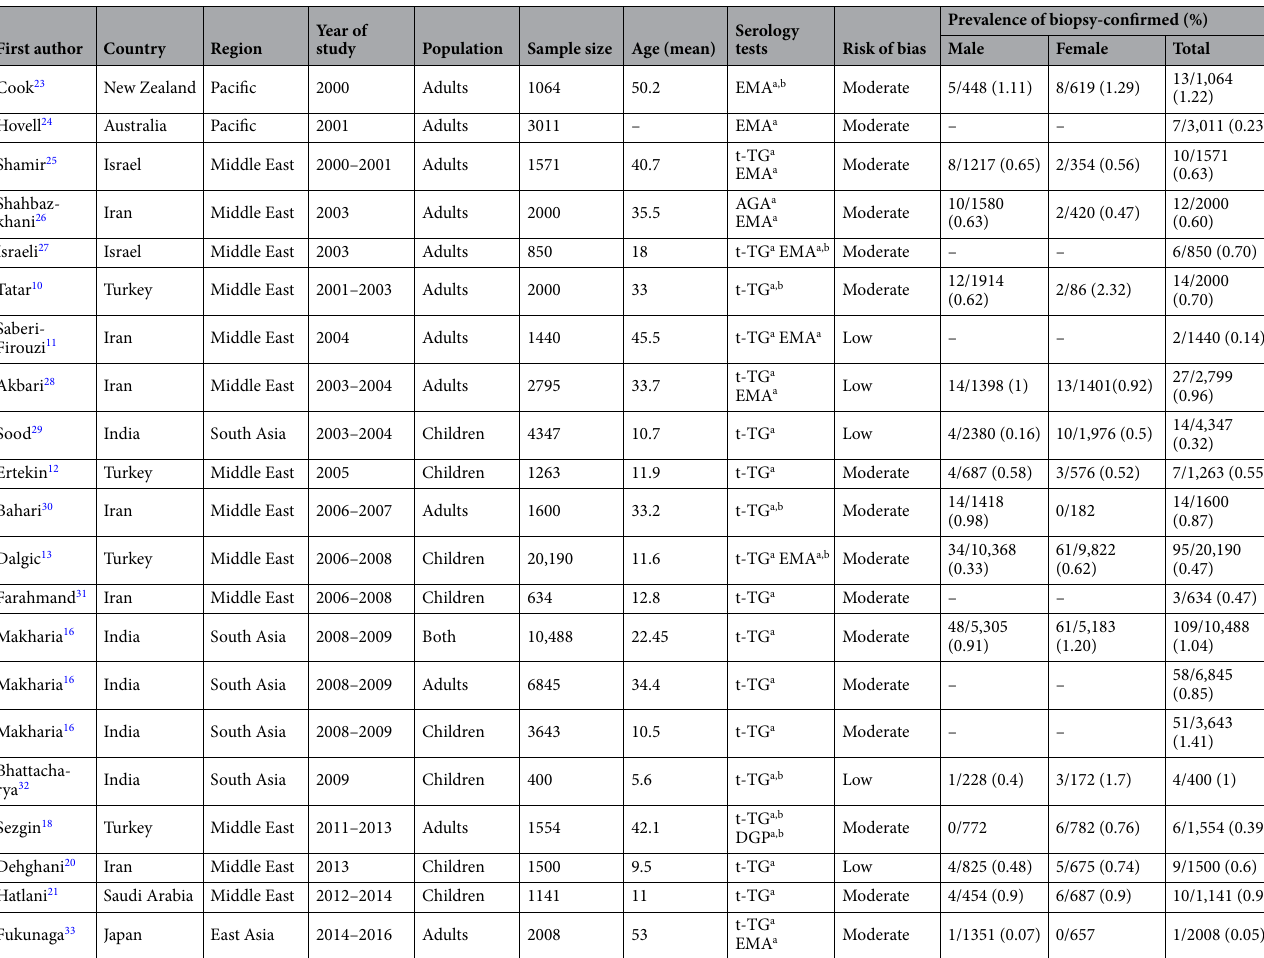
Table 2. Prevalence of biopsy-confirmed CD in Asia–Pacific region among not at-risk